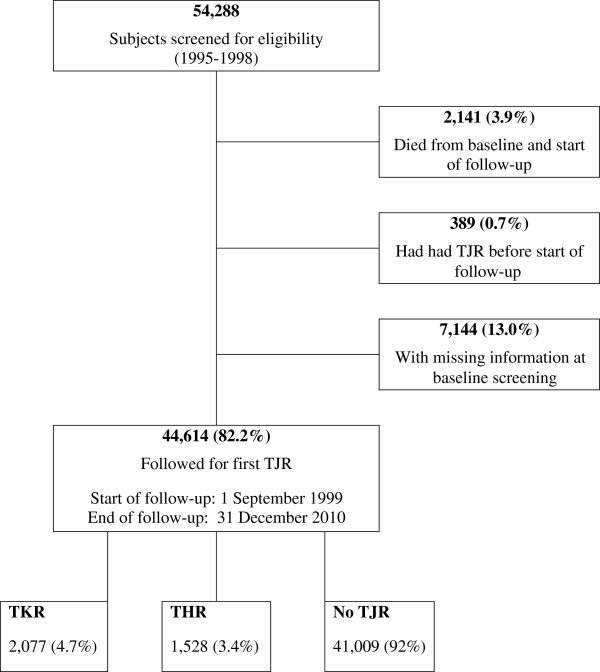
Flow chart of screening and follow-up for first total joint replacement due to osteoarthritis: the ANBP2 study.